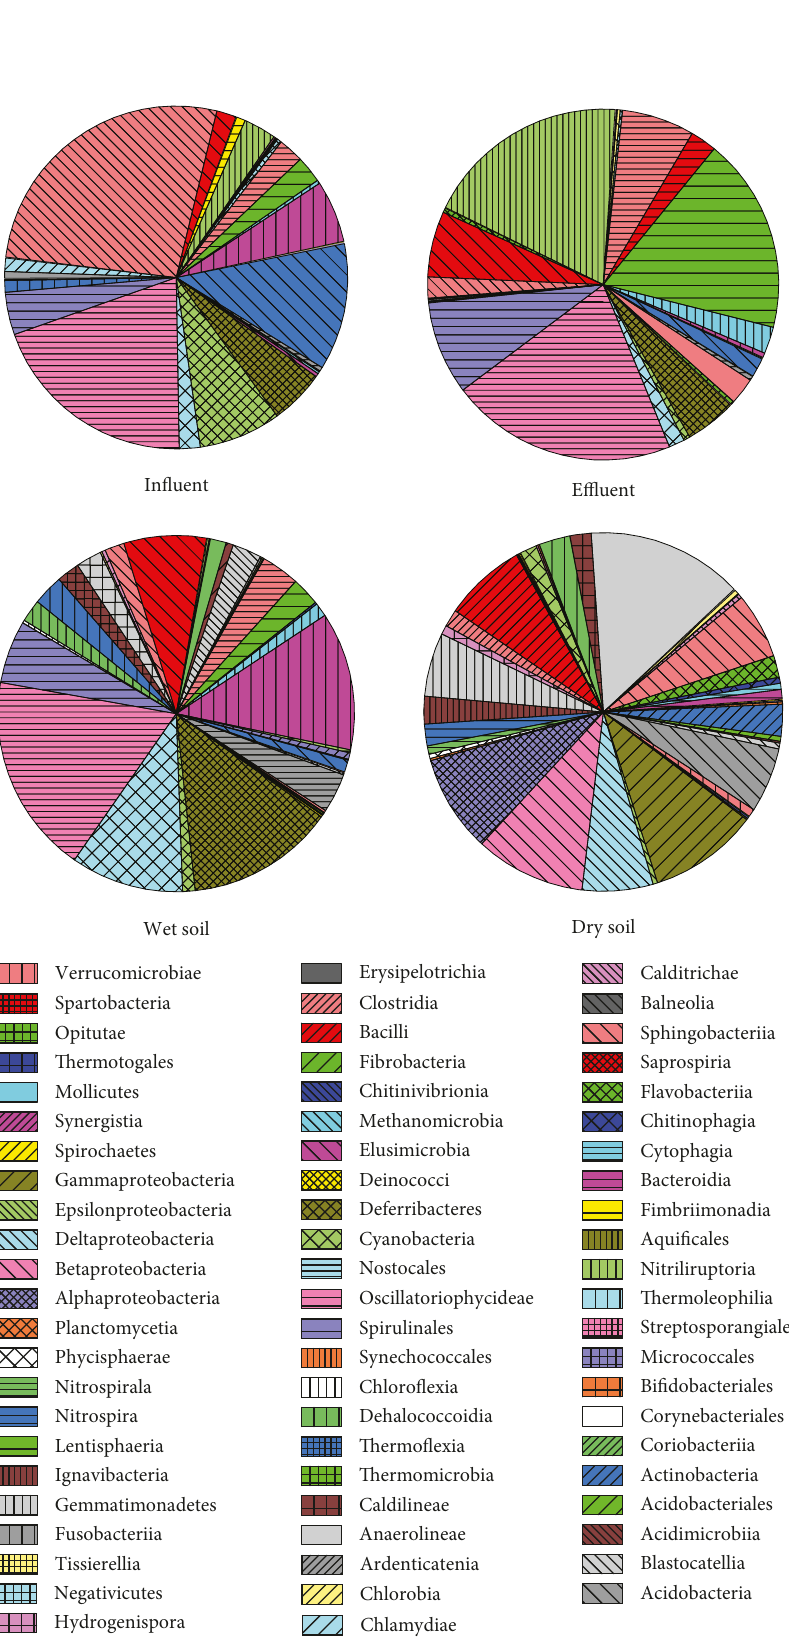
Figure 4: Bacterial relative abundance of four samples in classes in constructed